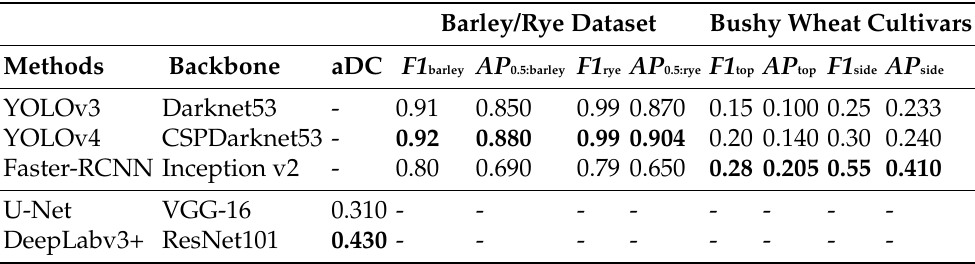
Figure 9. ( a – d ) shows detection examples of barley and rye spikes. White bounding boxes indicate spikes that were not detected by the DNN classifier in this particular image. Table 7. Summary of detection/segmentation DNNs performance evaluation on barley/rye spikes and bushy wheat cultivars. The best results, evaluated on F1 and AP are compared row-wise for barley/rye and bushy wheat cultivars and shown in bold. On barley/rye dataset, YOLOv4 performed better than Faster-RCNN, whereas DeepLabv3+ showed higher aDC, having more accurate spike boundaries. On Bushy wheat cultivars, DNNs failed to segment spikes. On side view bushy wheat cultivar images, Faster-RCNN achieved higher AP compared to top view wheat